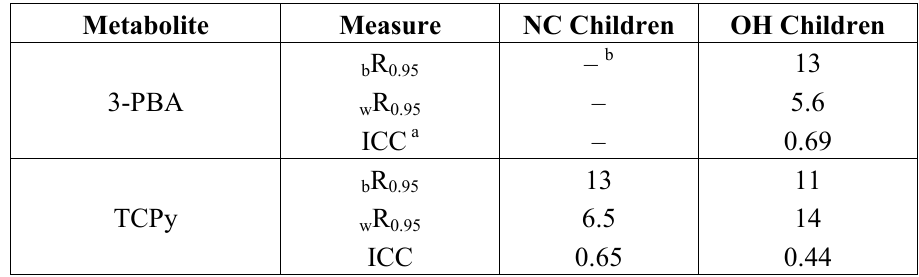
R and R ) and b 0.95 w 0.95